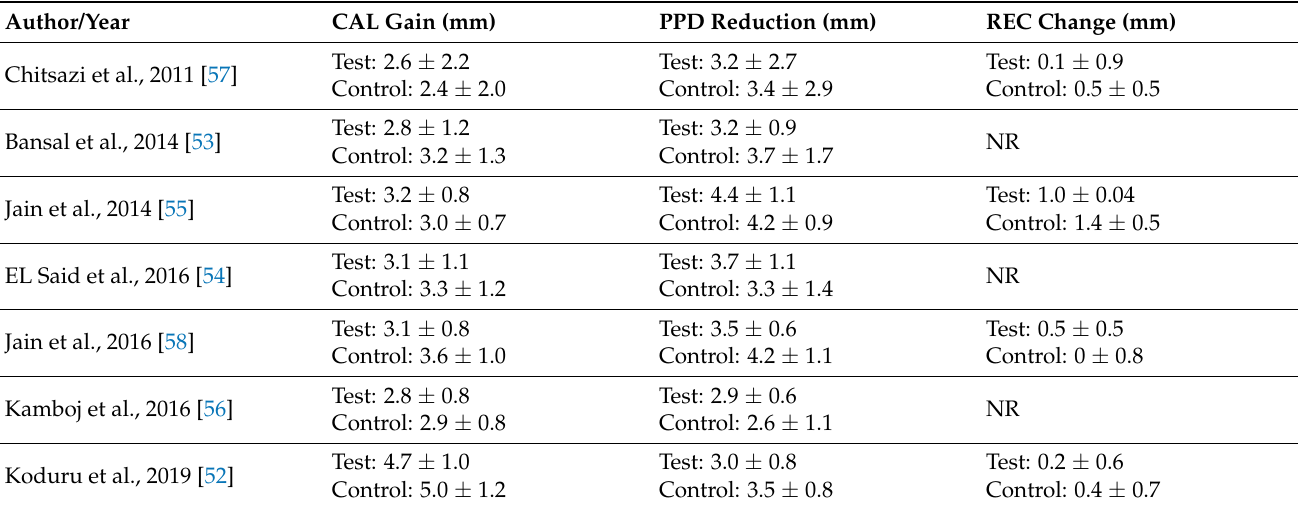
Table 4. Changes in CAL, PPD, and